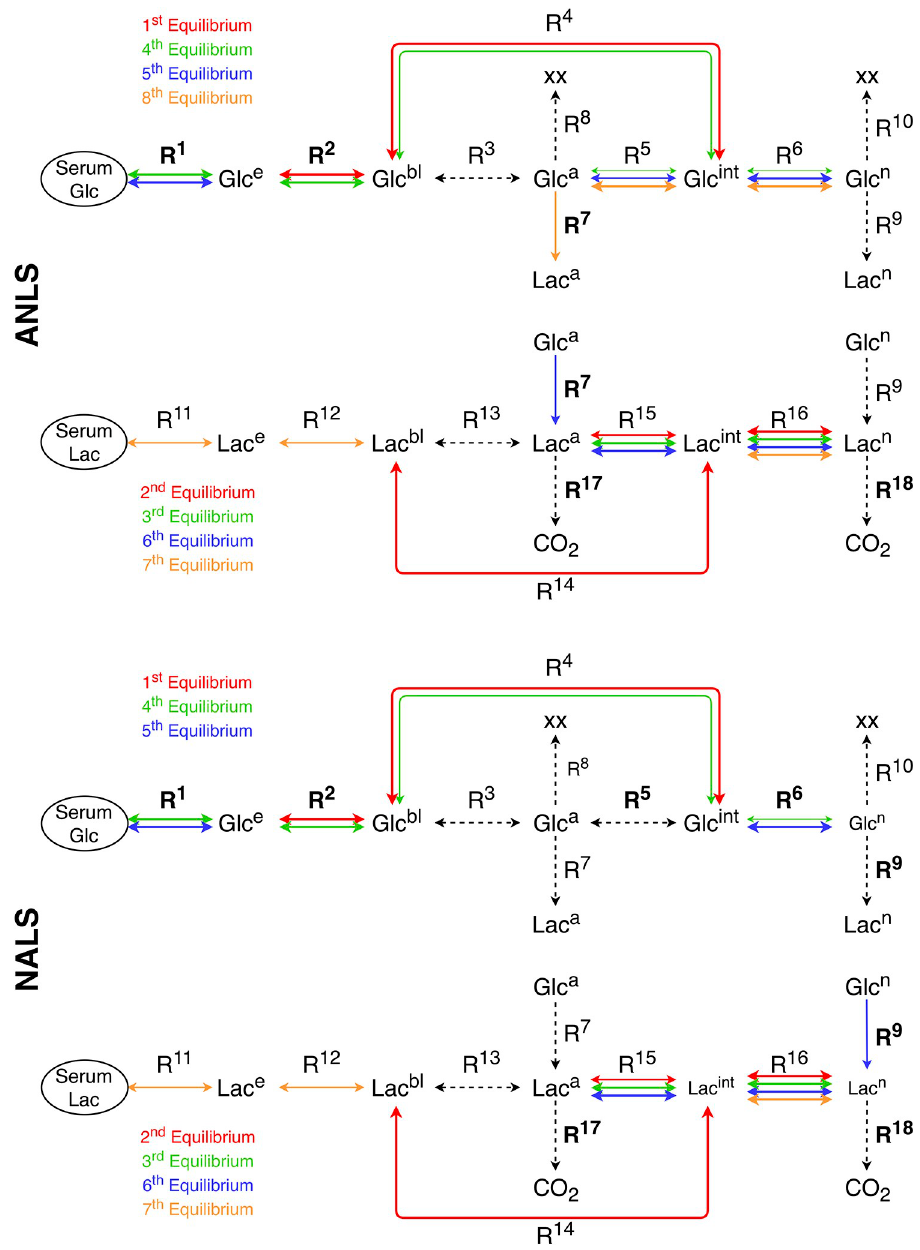
Fig 3. The constraints along the glucose and lactate paths. The constraints that develop along the Glucose and Lactate paths in the ANLS (top) and NALS (bottom) cases. Solid (dashed) arrows indicate reactions exhibiting large (small) APIs. The reactions within these constraints that drive the system (exhibit large IIs) are indicated by bold; see discussion of the slow model.